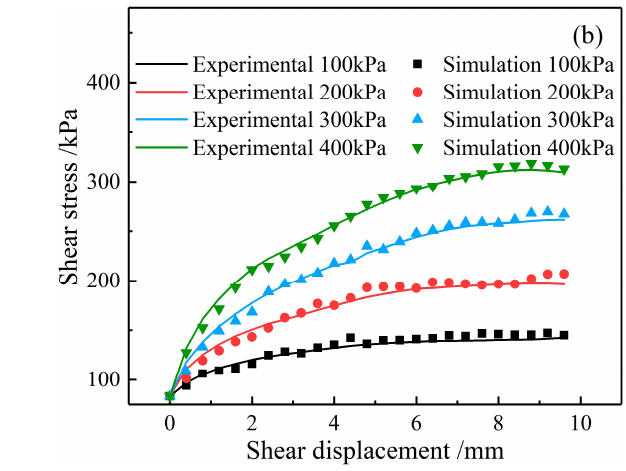
Figure 13.  -  curves: ( a ) N-L; ( b ) 2-L-5. Table 5. Micro-mechanical parameters of numerical model.